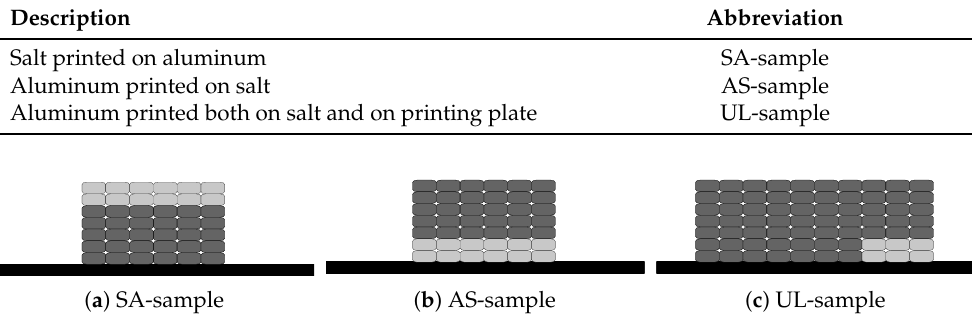
Figure 2. Schematic representation of the SA-sample ( a ), AS-sample ( b ) and UL-sample ( c ). Dark gray areas designate the aluminum part, light gray areas the support structure and black areas the heated nickel-plated steel printing plate.